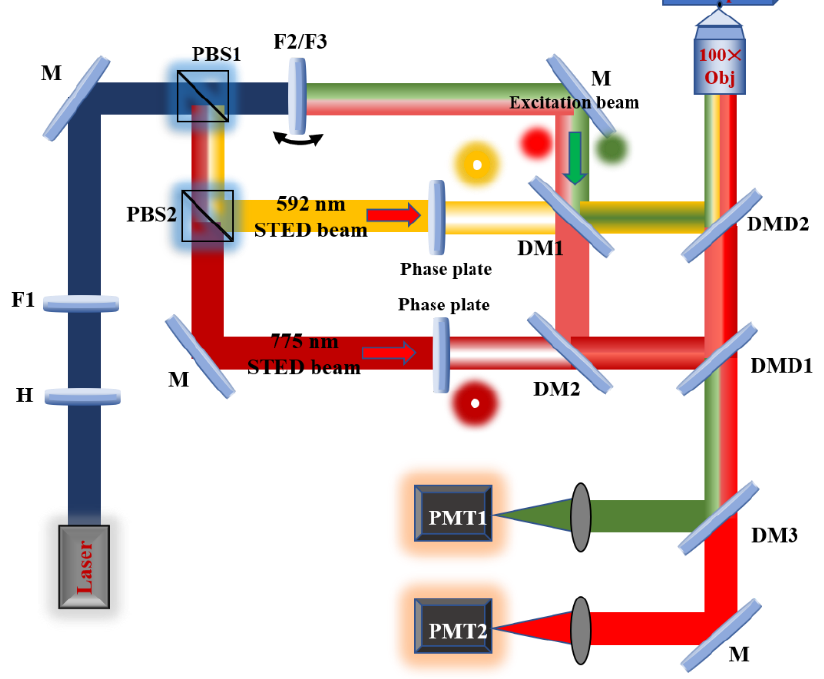
Figure 1. Schematic of two-color STED system.